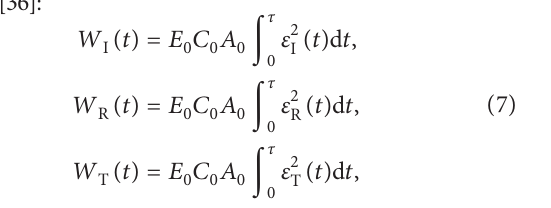
Figure 8: Failure modes of limestone specimen under different strain rates. (a) Without preload ( P ( P s � 2MPa).